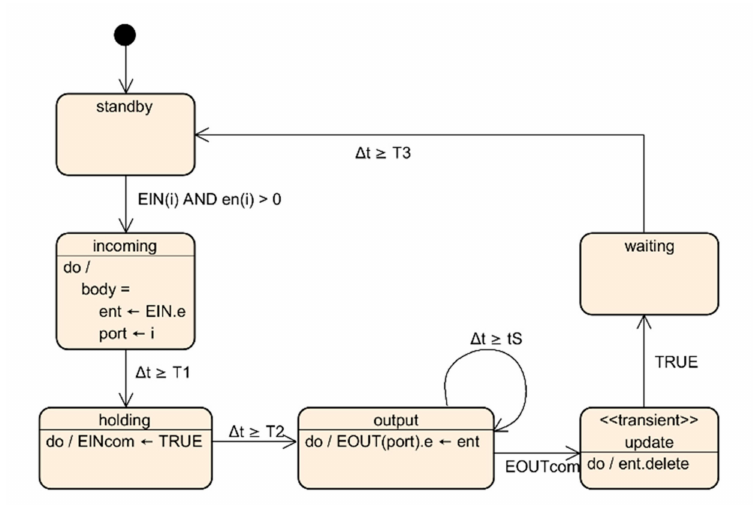
Figure 5. State machine for the handling